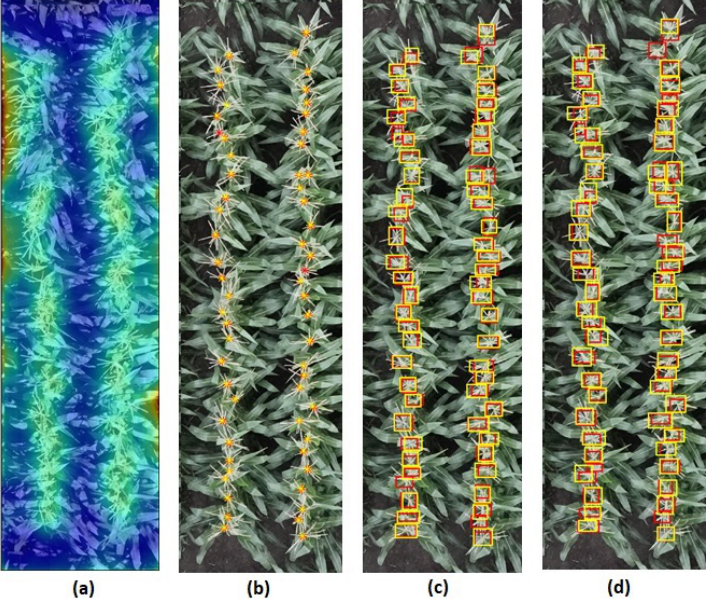
Figure 13. Results of Test Subset 4 (Ng: Red, TP: Yellow, FP: Cyan). ( a ) TasselNetv2+. ( b ) CenterNet. ( c ) TSD. ( d ) DetectoRS.